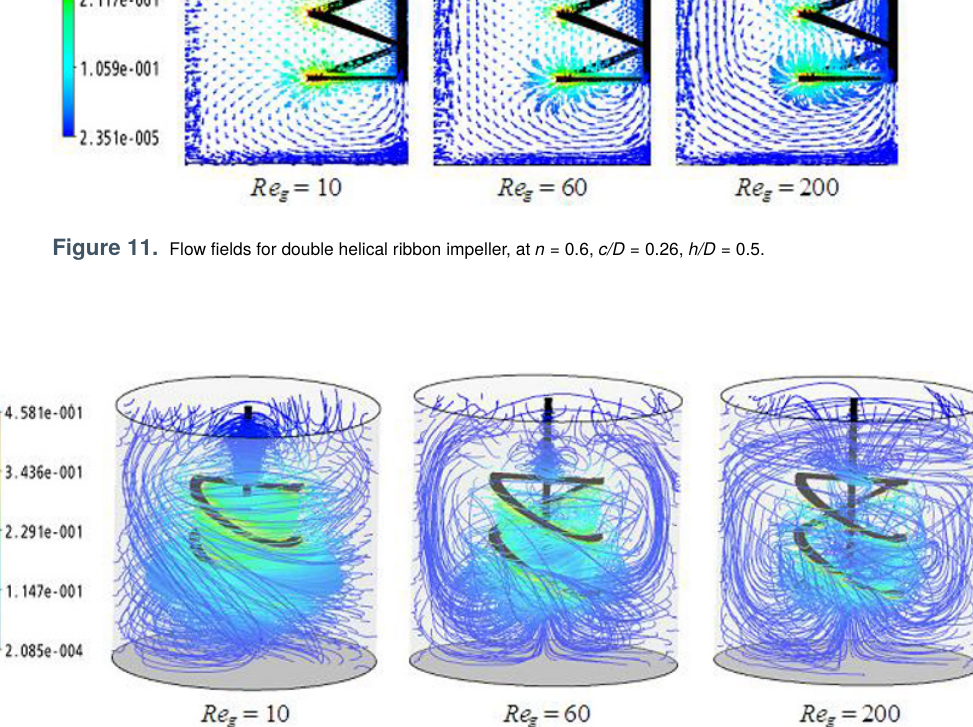
Figure 12. Streamlines for double helical ribbon impeller, n = 0.6, c/D = 0.26, h/D =